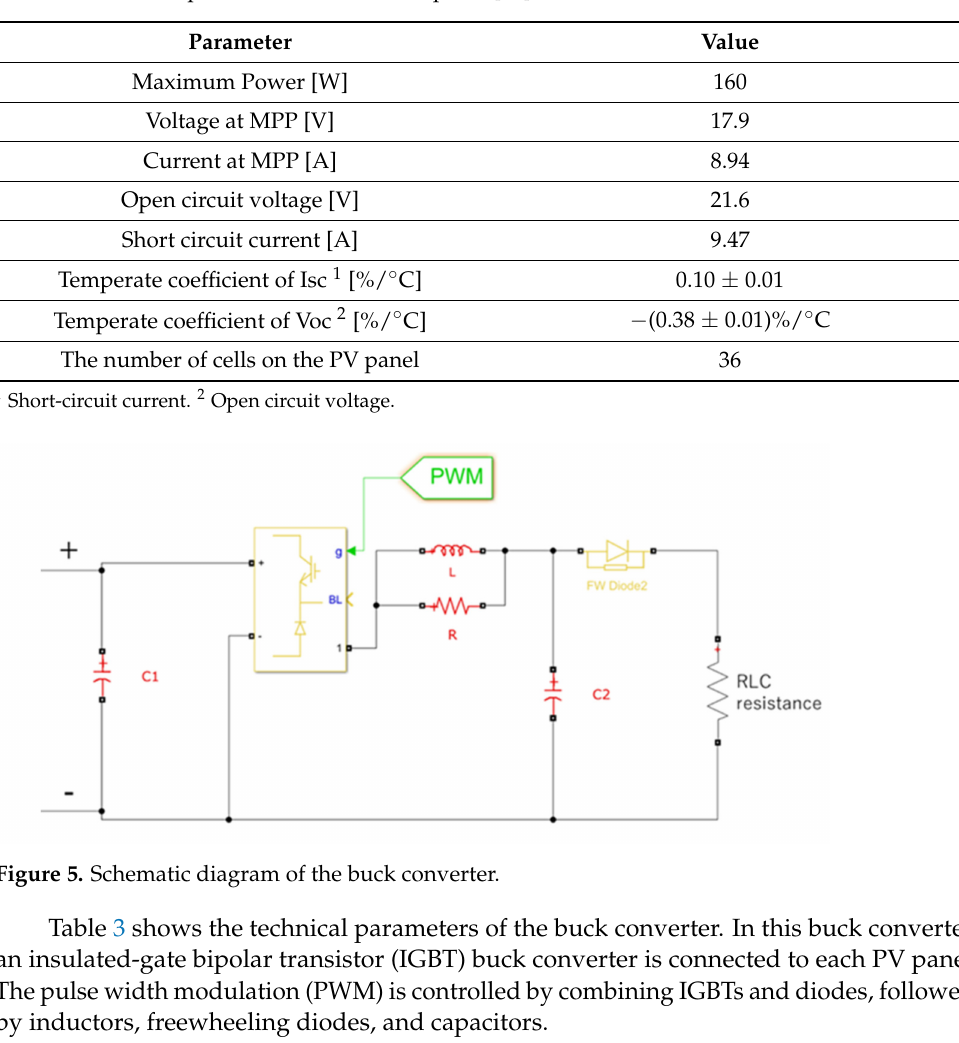
Table 2. Technical specifications of the solar panel [31].